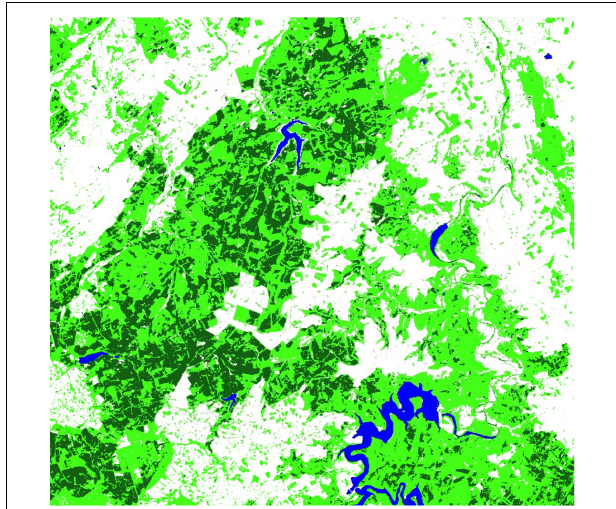
FIGURE 4 | Support Vector Machine (SVM) classification result of the Sentinel-2 2018 median composite of the Northern Eifel (dark green, spruce; light green, other forest; blue, water; and white, other).